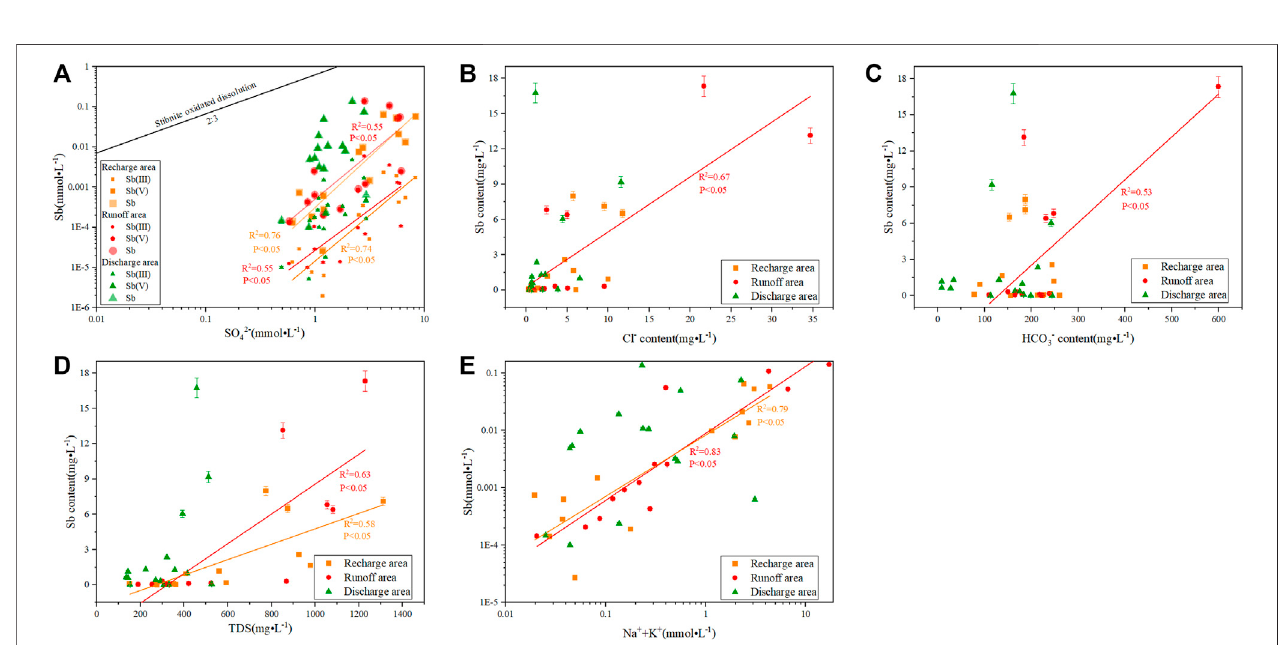
FIGURE 6 | Relationships between Sb content and the geochemical characteristics of the water samples: (A) Sb versus SO 42 − ; (B) Sb versus Cl − ; (C) Sb versus HCO 3 − ; (D) Sb versus TDS; (E) Sb versus Na + + K + .